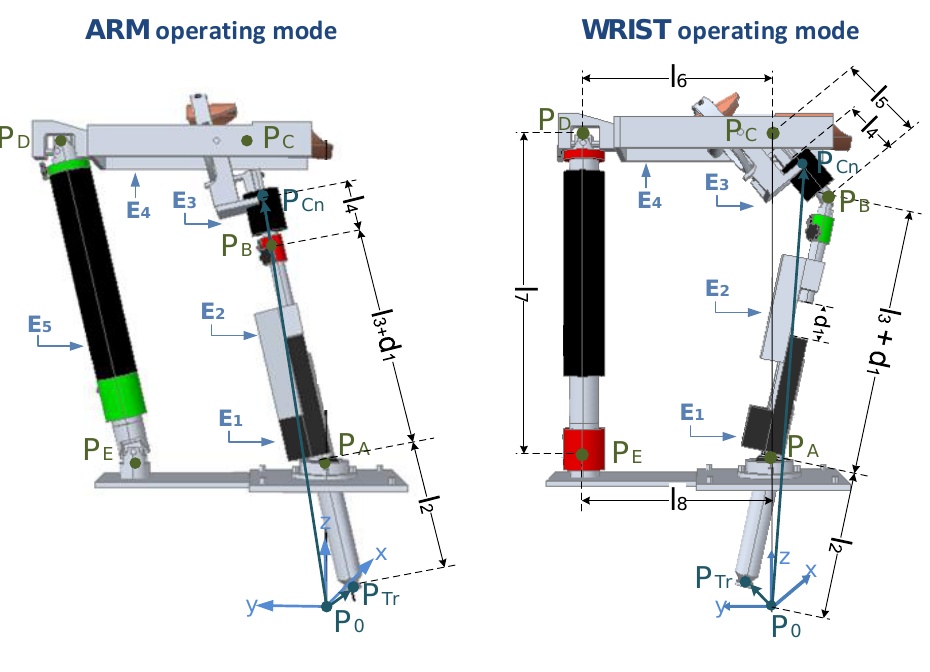
Figure 4. Pantograph structure of the UHP rehabilitation